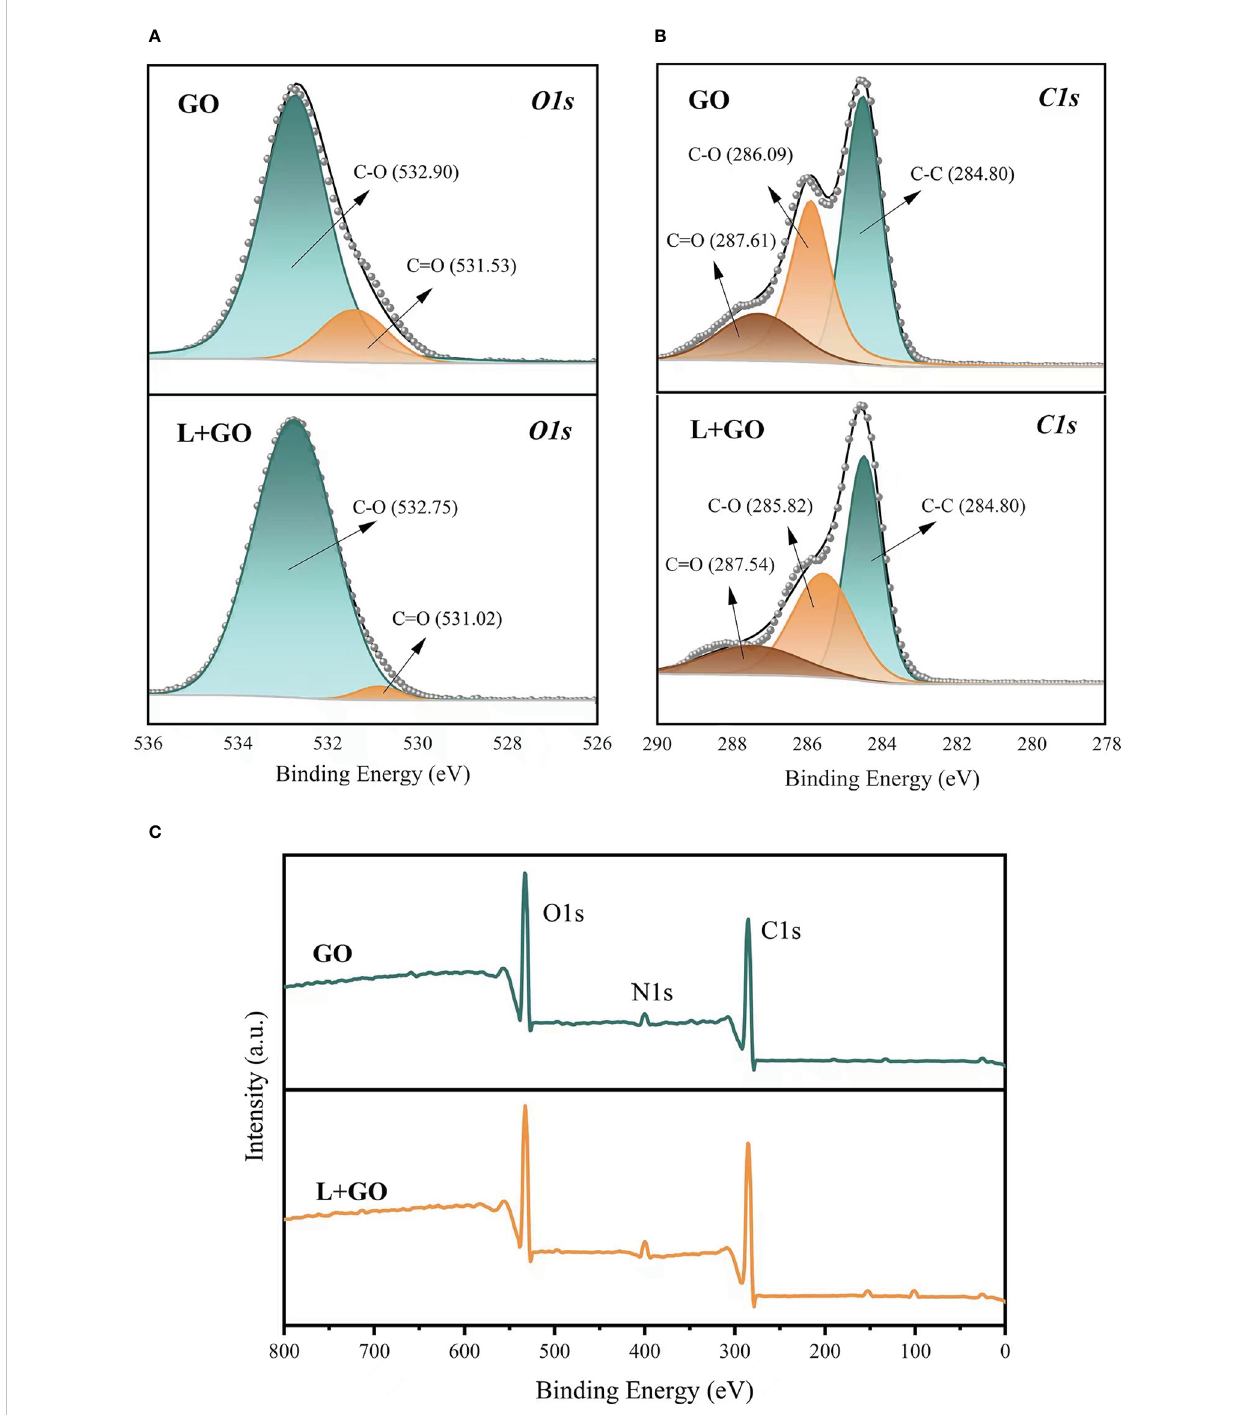
FIGURE 11 Characteristics of the stem incisions from the GO and L+GO groups examined by X-ray photoenergy spectra (XPS). (A) C1s XPS spectra. (B) O1s XPS spectra. (C) XPS wide